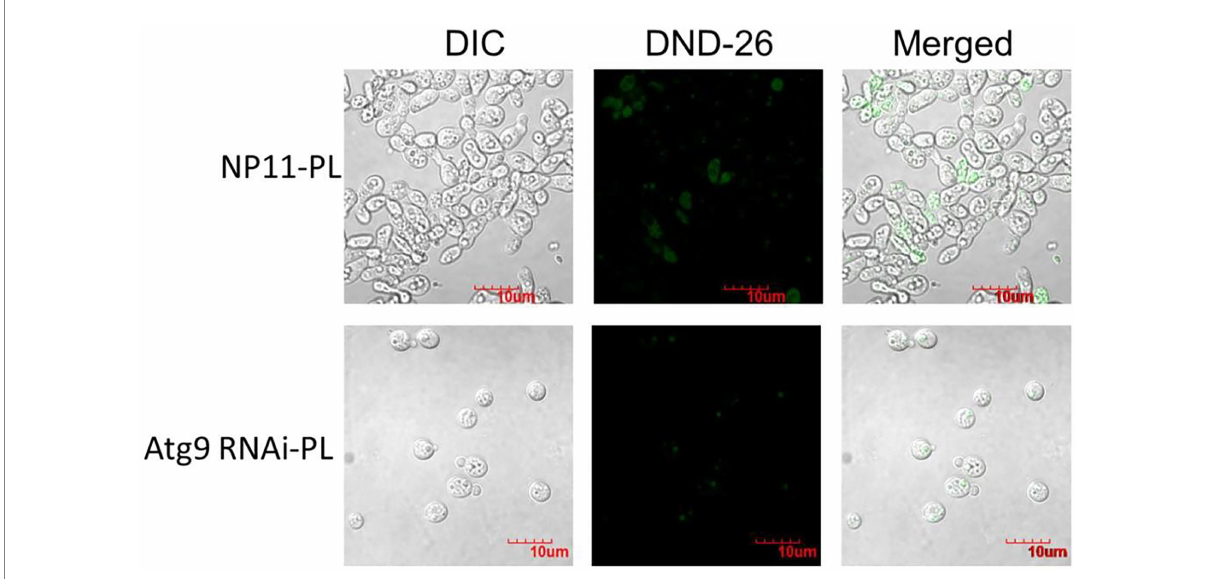
FIGURE 5 The R . toruloides WT and RNAi strains cultured in the PL medium with the fluorescence microscope after LysoTracker® Green DND-26 staining.